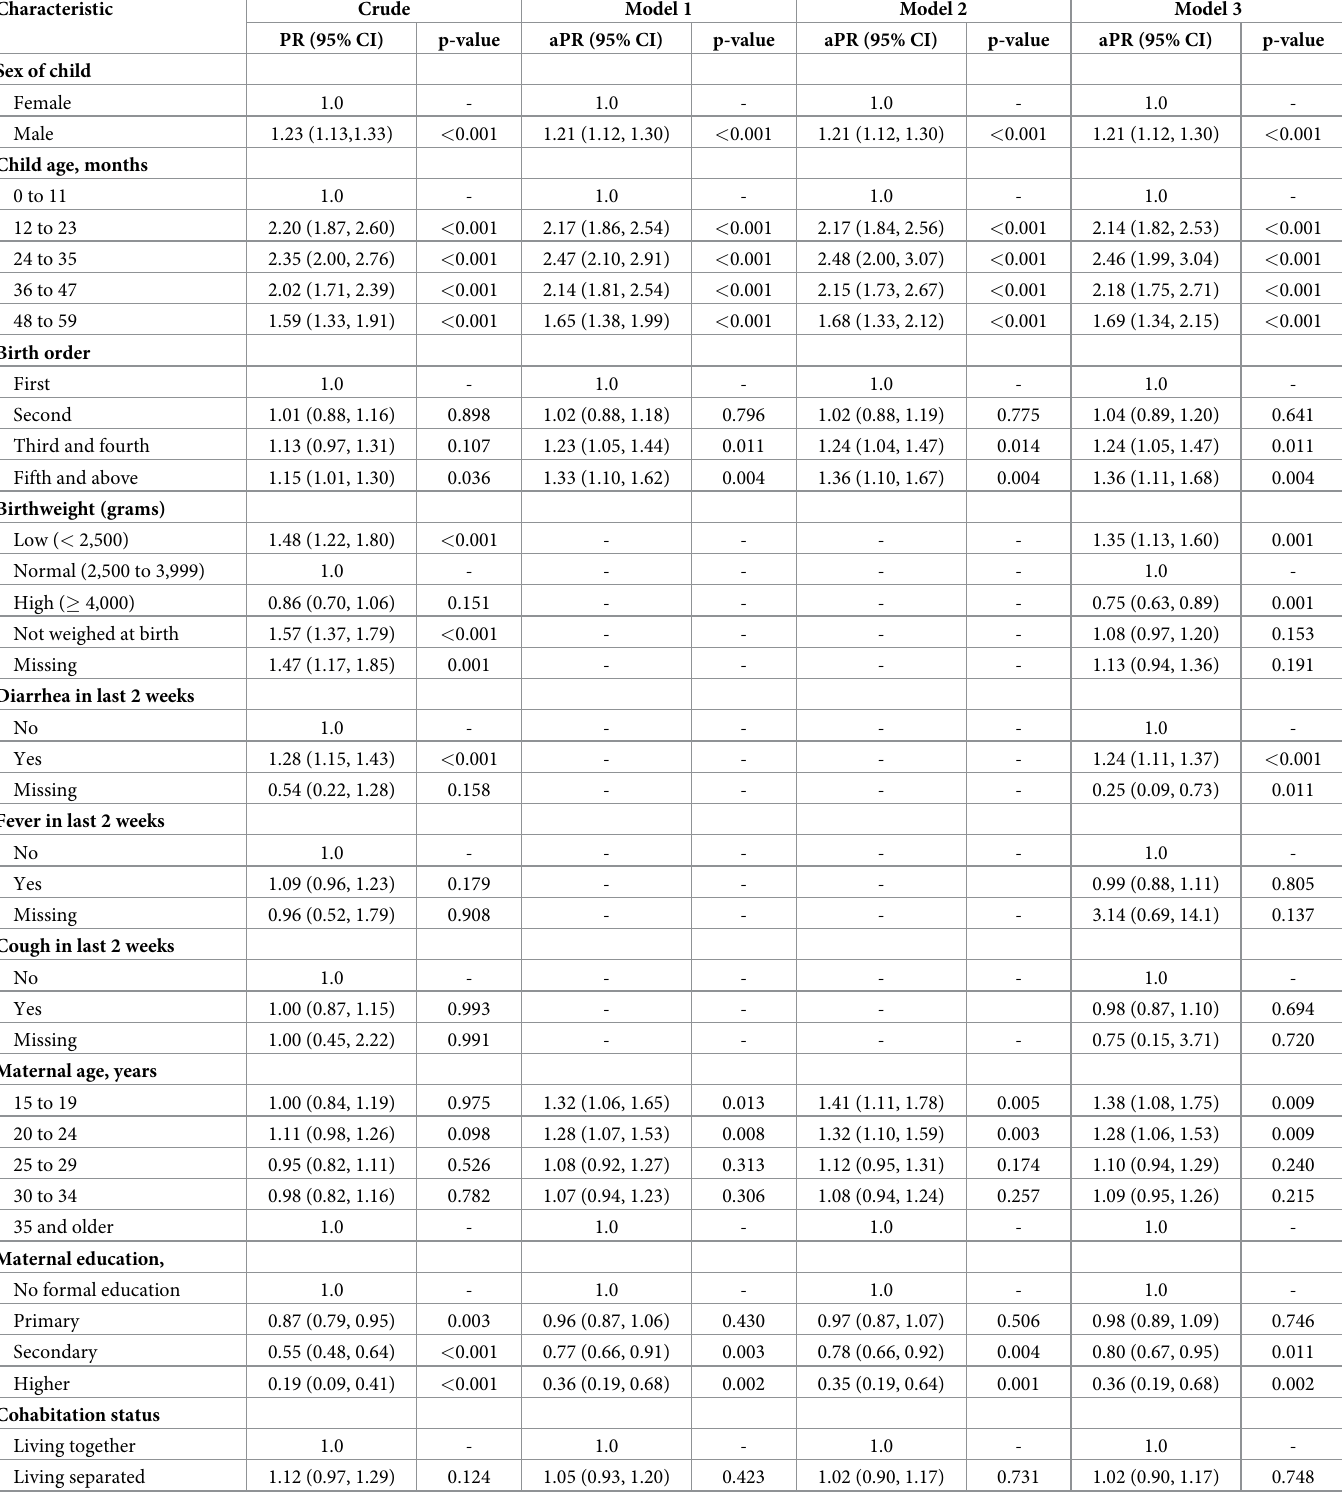
Table 2. Crude and adjusted prevalence ratio of stunting according to characteristics of participants and households.